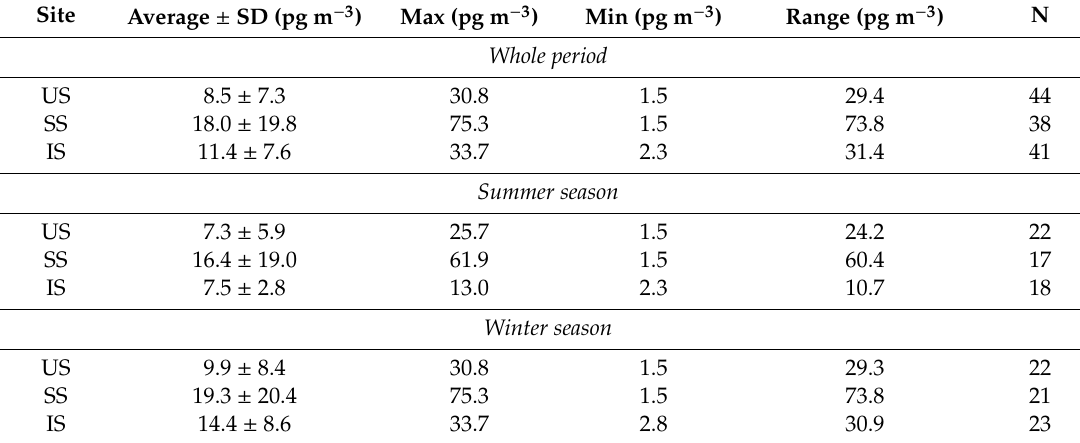
Table 1. Average, SD, range and minimum and maximum values of PHg in PM 10 samples at urban site (US), suburban site (SS) and industrial site